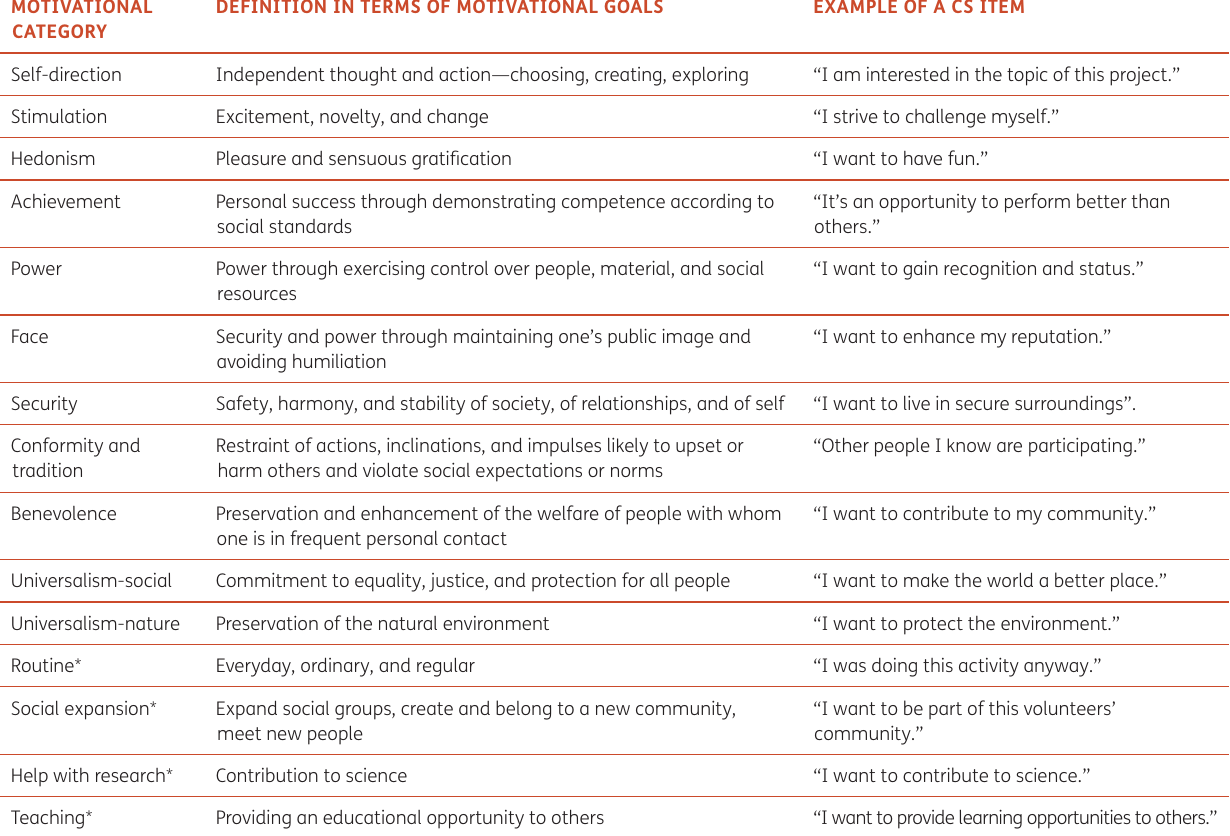
Table 1 Definition of the 15 motivational categories measured in the citizen science motivation scale (CSMS) and examples of CS items. The first 11 categories are theory driven and represent basic values based on Schwartz (1992) and Schwartz et al. (2012), whereas the last four (marked with *) are data-driven categories based on previous CS